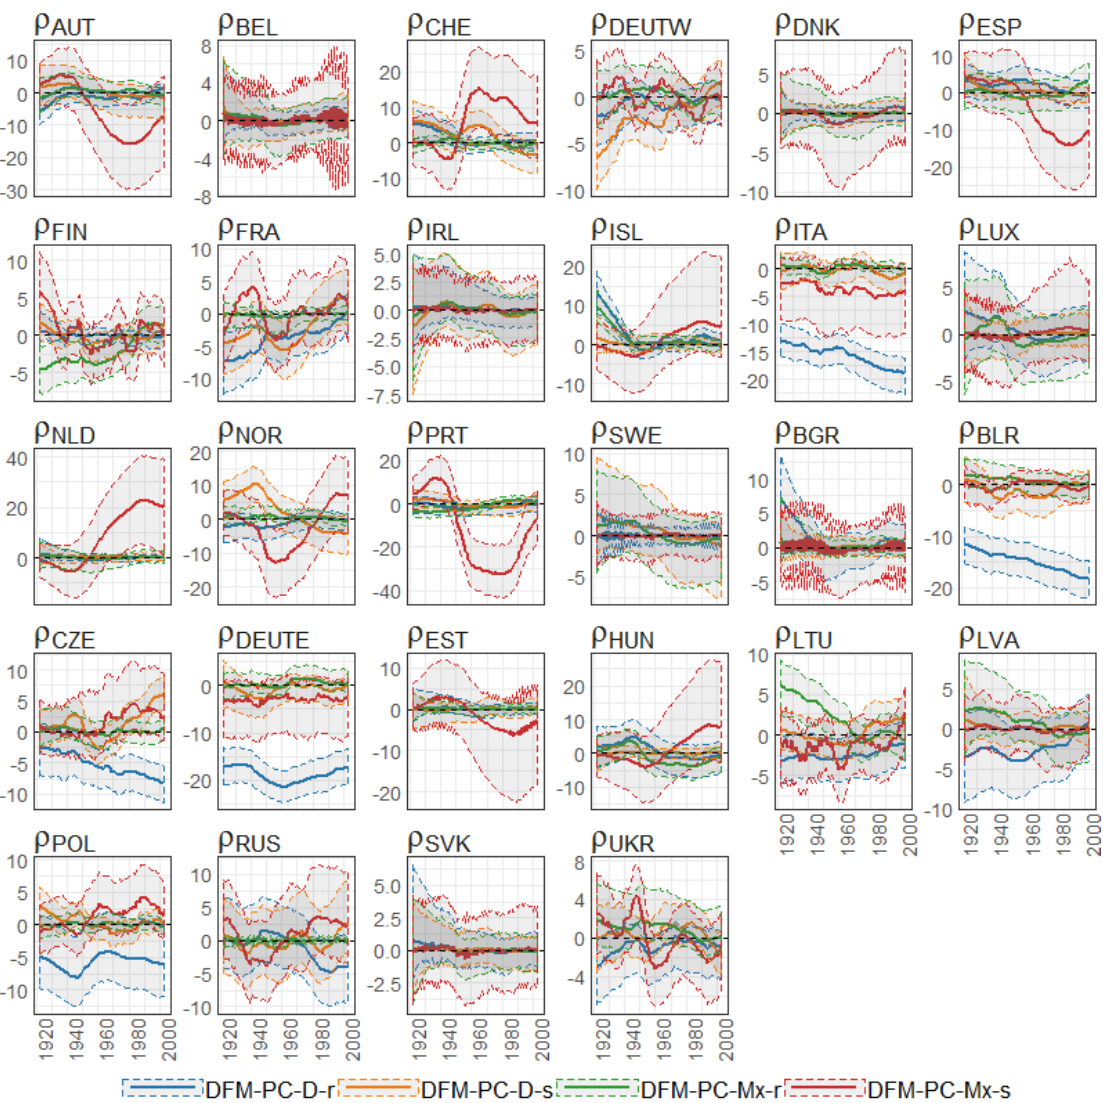
Figure 36. The Bayesian posterior mean estimates with 95% posterior credible intervals for (cid:36) t across countries (different panels) overtime (x axis) under the models from the classes DFM-PC-D and DFM-PC-Mx (colours of lines) for British female log death rates during